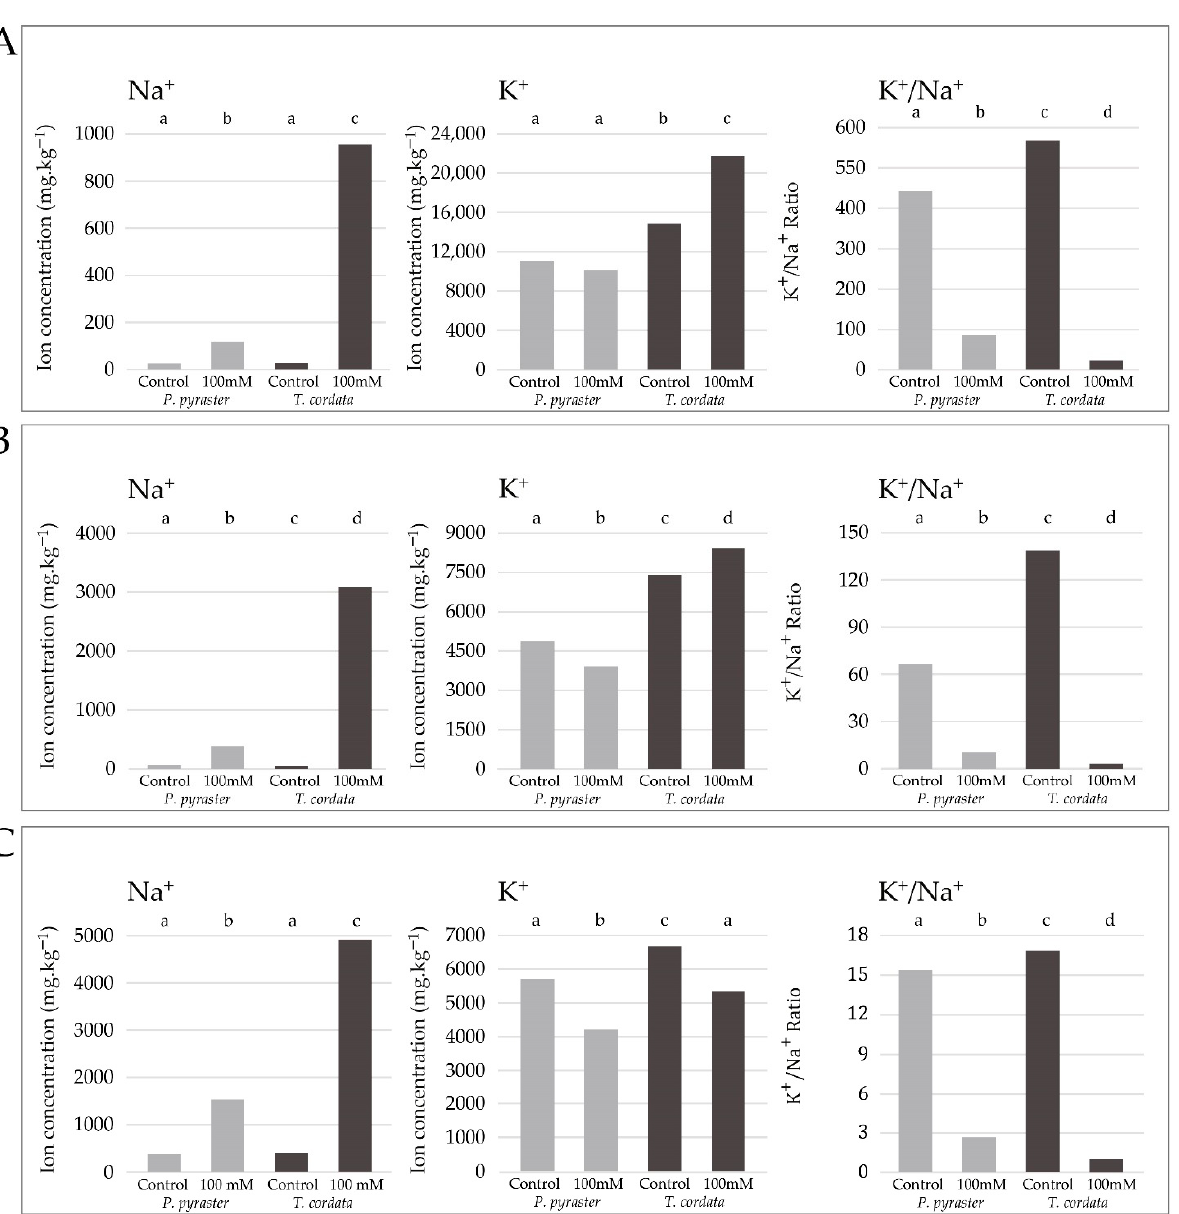
Figure 5. The salt ion content (Na + , K + , and K + /Na + ) in the ( A ) leaves, ( B ) stems, and ( C ) roots of two-year-old seedlings of P. pyraster and T. cordata after 50 days of continuous 100 mM NaCl saline application and in the control. The bars indicate the mean values of the ion content in the plant organs from a sample of 10 plants. Significant differences ( p ˂ 0.05) are indicated by different letters.